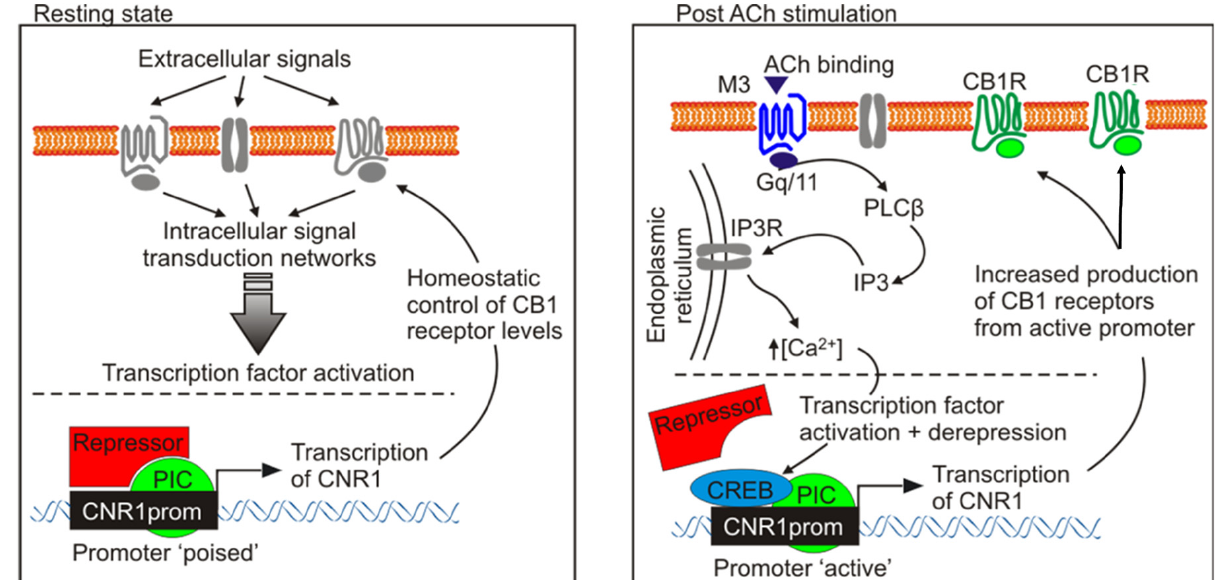
Figure 8. The proximal promoter region of CNR1 from a poised to an active state after ACh ‘priming’. Schematic representation of the proposed G α q/11 -G α i/o functional cross-talk, in SH-SY5Y neuroblastoma cells. At resting state (left panel) the CNR1 promoter is in a repressed state (poised promoter), allowing only the homeostatic control of CB 1 receptors level. When primed with ACh, the M 3 receptor signaling pathway is responsible for de-repressing the CNR1 promoter (unpoised promoter), that now becoming accessible to CREB, can actively promote active CNR1 gene transcription (right panel). PIC: promoter-bound preinitiation complex, which consists of RNA polymerase II and general transcription factors.